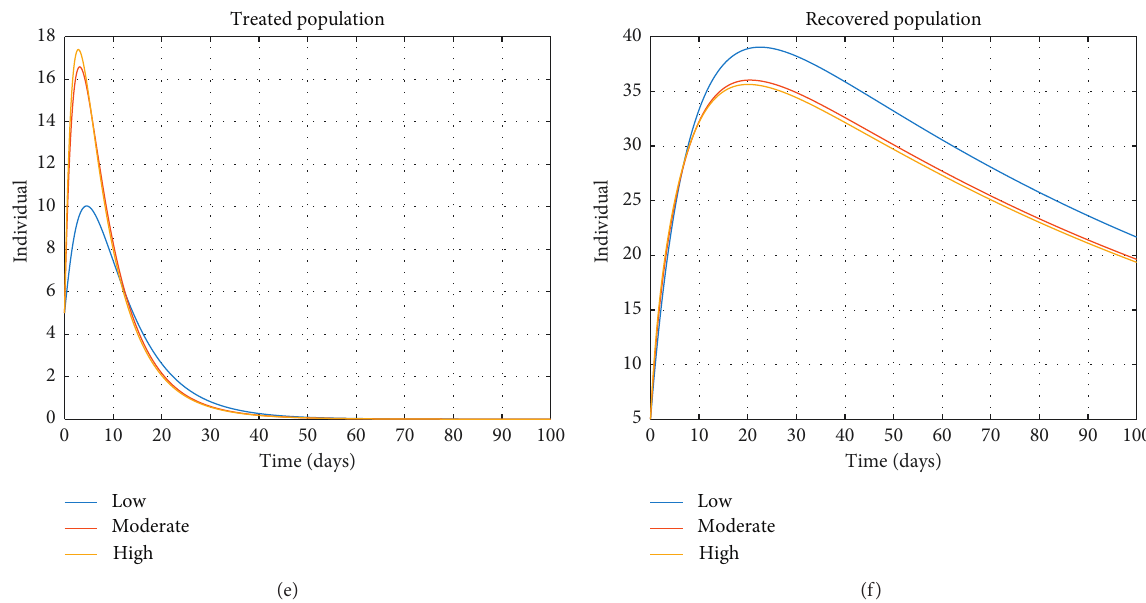
Figure 5: The effect of vaccination coverage, therapy and treatment under low, moderate and high scenarios.